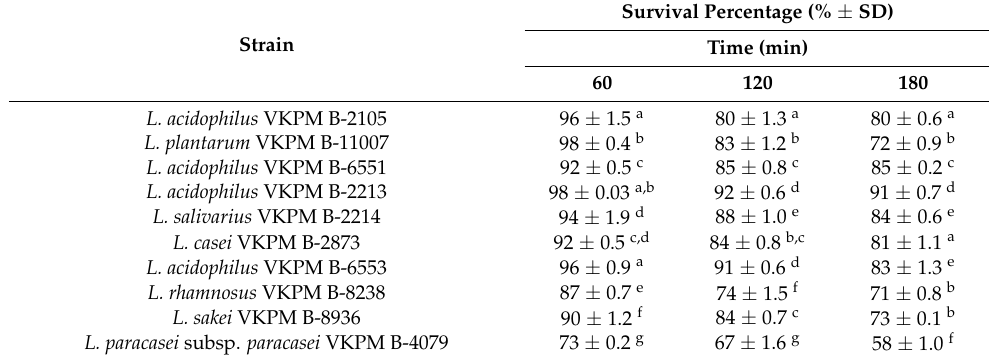
Table 6. Tolerance of Lactobacillus strains to pepsin.